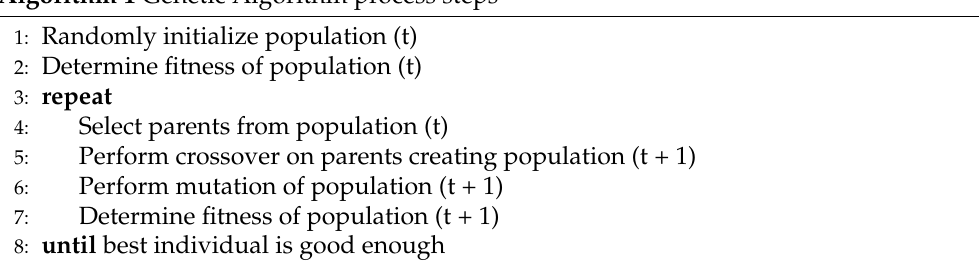
Algorithm 1 Genetic Algorithm process